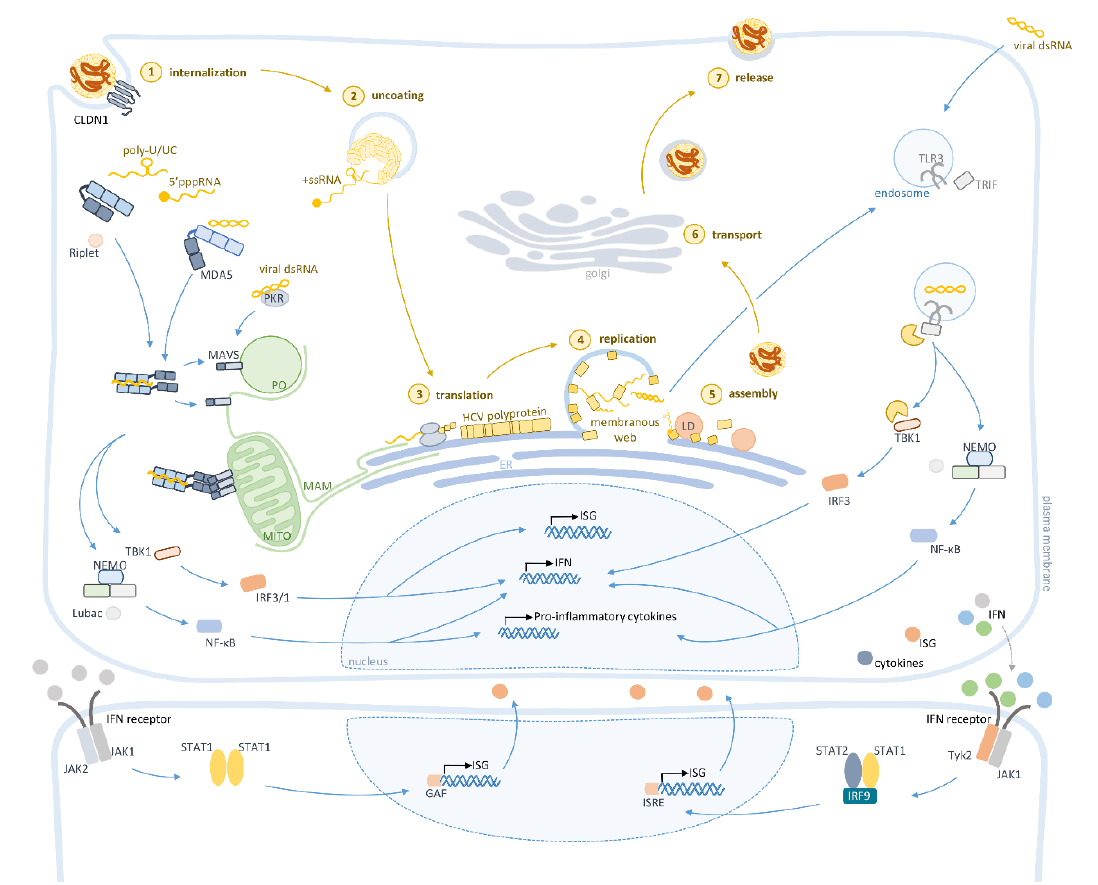
Figure 2. Hepatitis C virus (HCV) sensing by the intracellular innate immunity throughout the virus life cycle. Upon attachment to cellular receptors, HCV is internalized by endocytosis (1). Uncoating is then triggered and the viral genome is released into the cytoplasm (2). At the endoplasmic reticulum (ER) surface, viral RNA is translated (3), producing a polyprotein that it is co- and post-translationally processed into 10 viral proteins. Viral proteins’ expression induces the formation of a membranous web, which is essential for viral replication (4). HCV hijacks the lipid transport machinery for assembly (5) and uses the endosomal secretory pathway to be transported to the plasma membrane (6), where virion release occurs (7). The cytosolic sensors retinoic acid-inducible gene-I (RIG-I), melanoma differentiation-associated protein 5 (MDA5) and protein kinase R (PKR) together with the membrane pattern recognition receptor toll-like receptor 3 (TLR3) recognize viral RNA inducing the downstream activation of interferons (IFNs) and proinflammatory cytokines’ production.3. Activation of the Intracellular Innate Immunity by